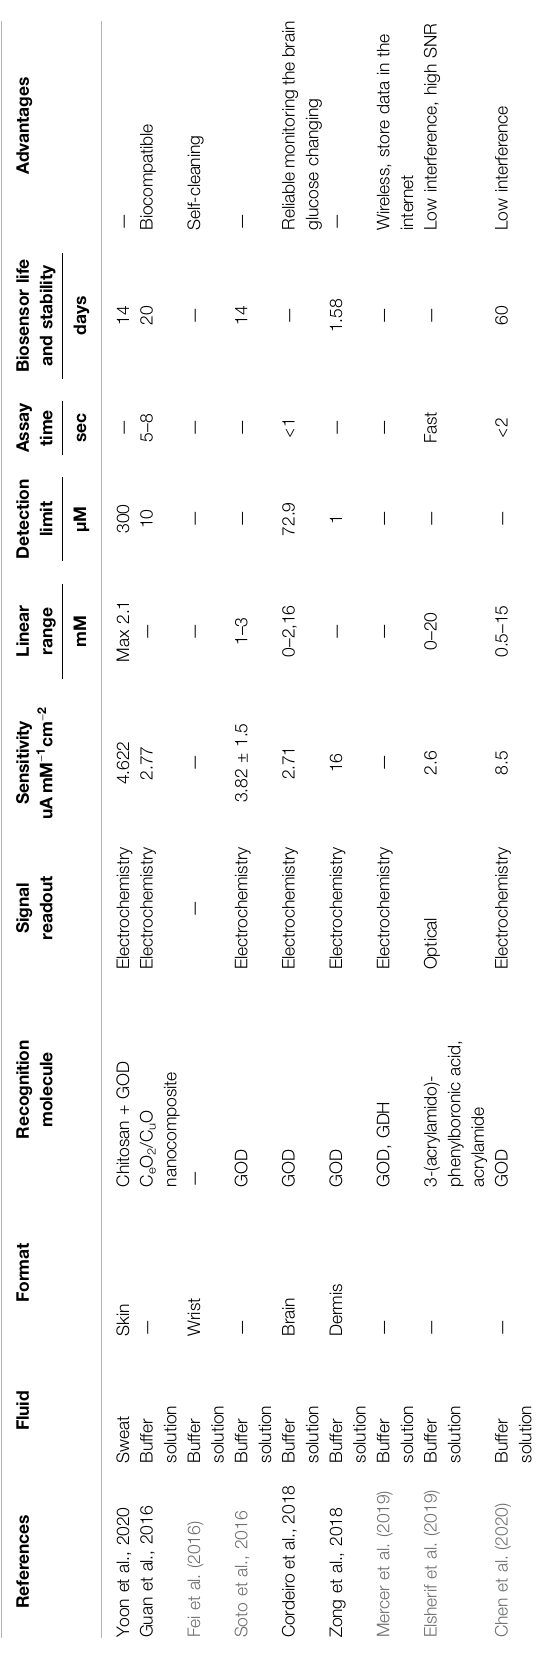
shows a very good sensitivity of 684 nA mM − 1 mm − 2 , a linear range of up to 30 mM, and a response time of 15 s (Yoon et al., 2018). This device makes use of hydrogen atoms on the platinum surface, which oxidise glucose molecules to glucono δ -lactone, using amperometry as a measurement method. Figure 2C (1) indicates the level of skin reached by the sensor as being subcutaneous tissue, Figure 2C (2) represents the three electrodes that make up the device. Finally, Figure 2C (3-4) shows how the pore size and shape are permeable to glucose molecules but reject interferences such as ascorbic acid.